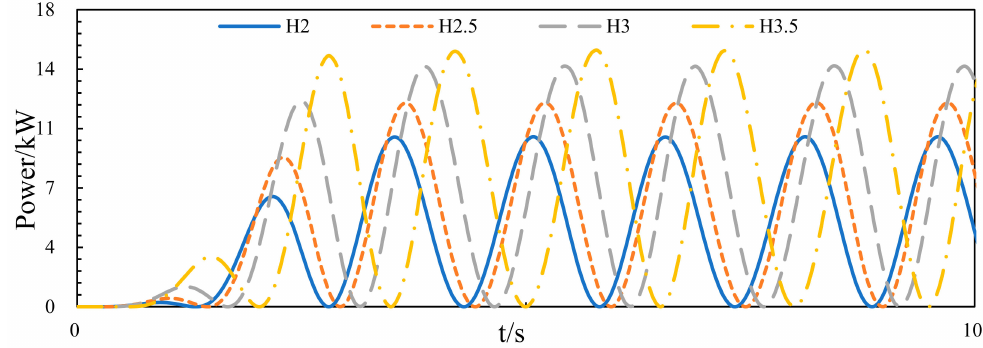
Figure 17. The instantaneous power curves of Buoy